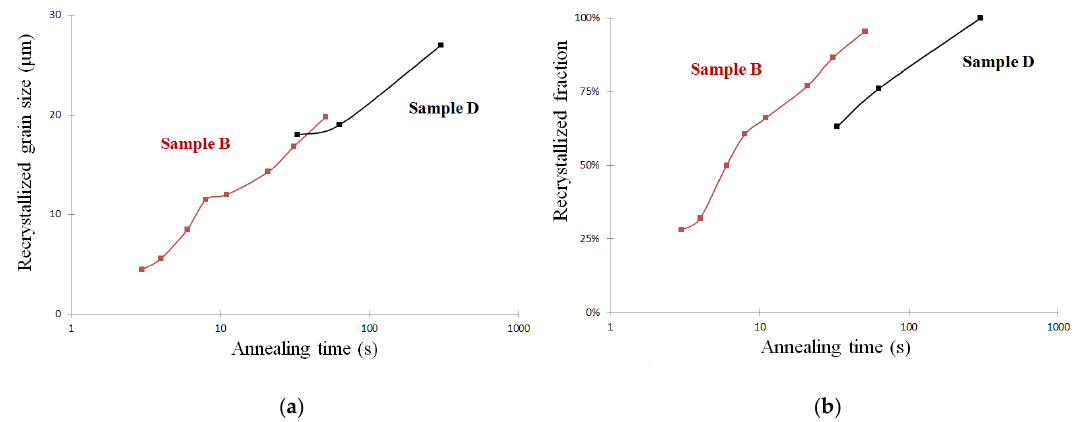
Figure 7. Post ‐ dynamic recrystallization kinetics obtained with in situ annealing procedure applied onto sample B or with holding time applied onto samples D before water quenching at the end of deformation. Same deformation conditions for both data series: up to 0.55 strain at 1020 °C and 0.1 s − 1 . ( a ) Average recrystallized grain size; ( b ) Recrystallized volume fraction.